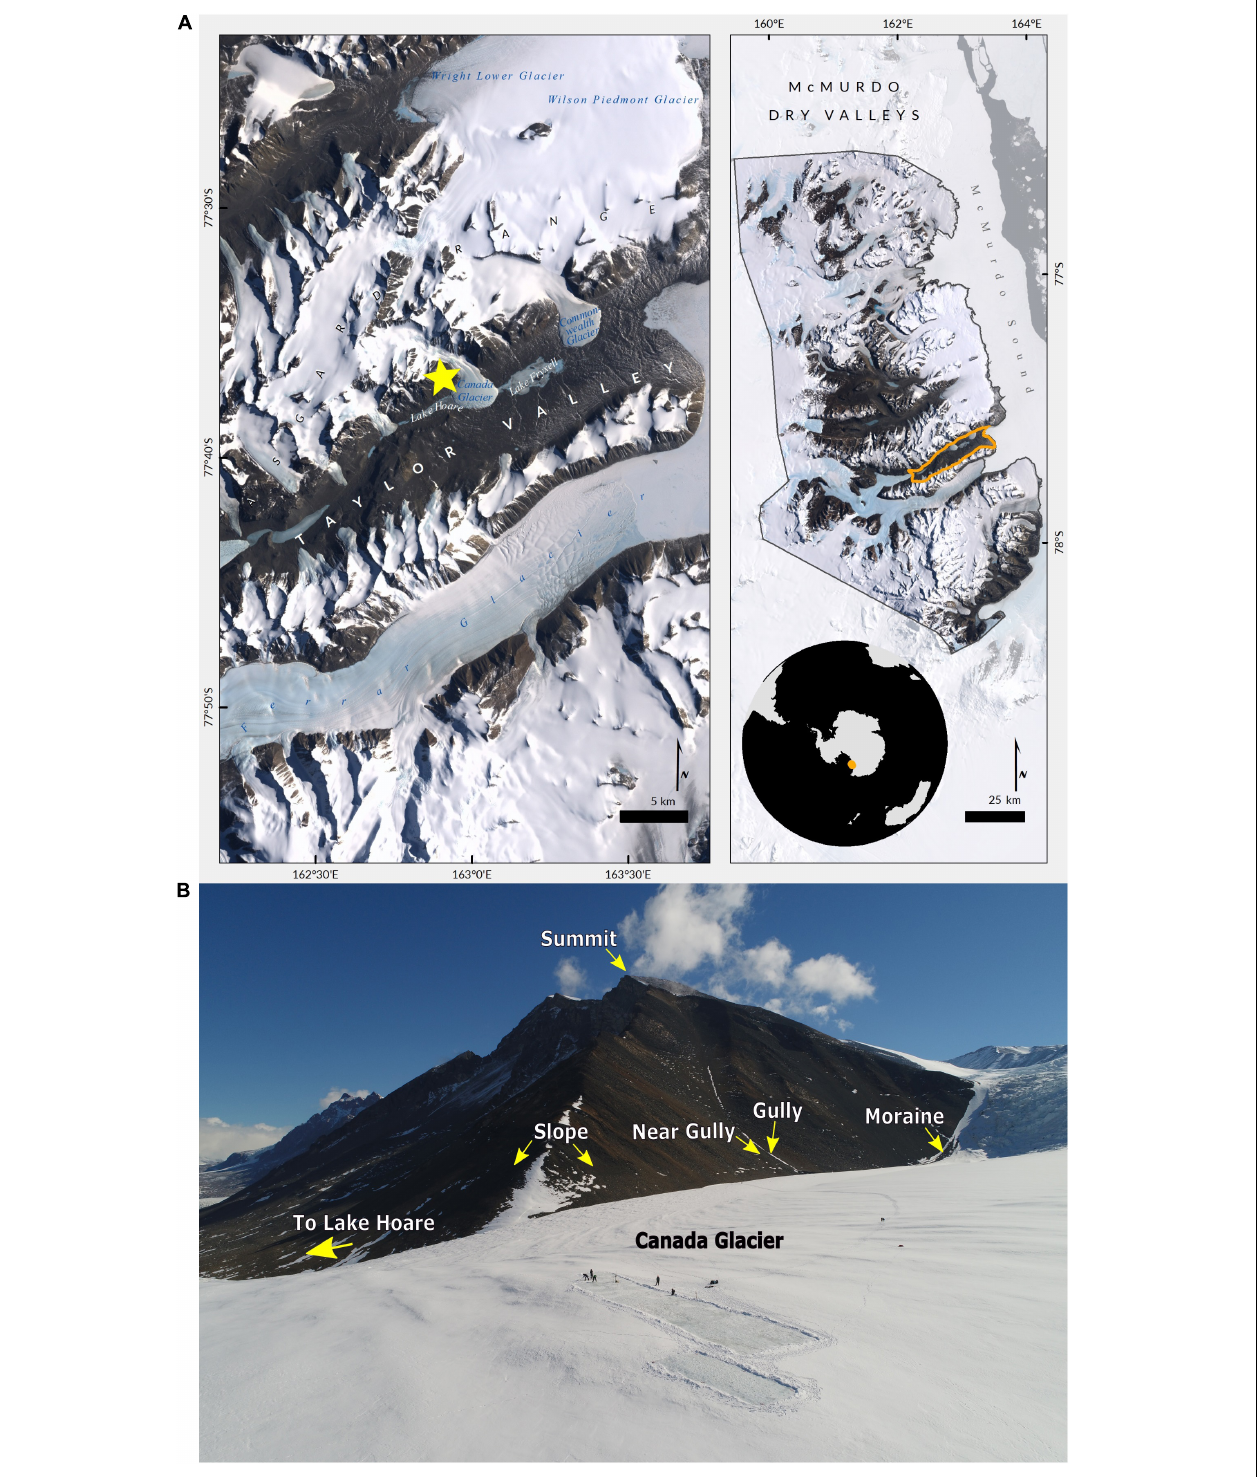
FIGURE 1 | Research site. (A) Satellite map of the McMurdo Dry Valleys (right) and Taylor Valley Valley (left). The yellow star identifies the location of the area sampled within the Asgard Range (images: Cathleen Torres Parisian, Polar Geospatial Center). (B) View from drone taken above Canada Glacier with arrows pointing to the habitats sampled in this study, and other key landmarks (photo: Brendan Hodge,